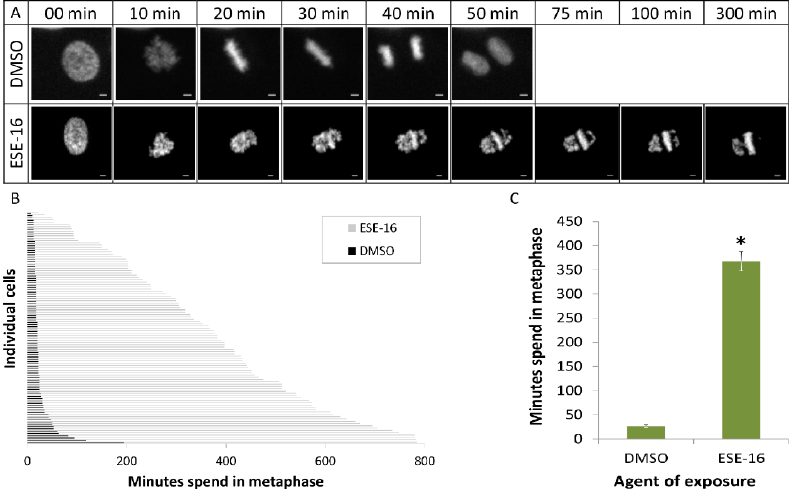
Figure 7. Time-lapse imaging of HeLa Kyoto cells exposed ESE-16. ( A ) Selected frames from time-lapse imaging of HeLa Kyoto cells exposed to 0.4 µM ESE-16 illustrating misaligned chromosomes. Scale bars = 10 µm. ( B ) Analysis of the duration of metaphasis in HeLa Kyoto cells treated with DMSO (control) or with ESE-16, as indicated. Duration of metaphase was analysed from the representative time-lapse imaging experiments shown in A. The data represent 100 cells of each treatment. ( C ) Bars indicate average time spent in metaphase (100 individual cells), with the SEM represented by T-bars, * p < 0.001).